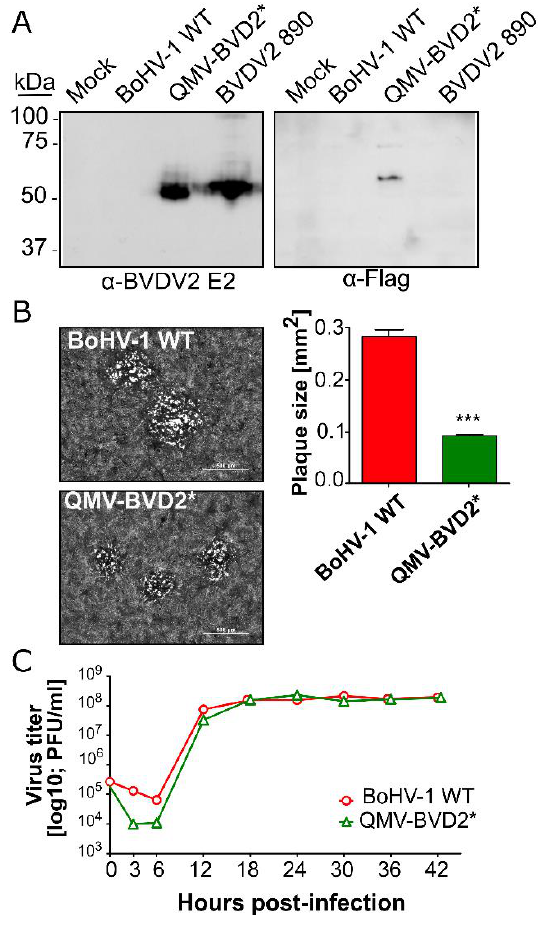
Figure 4. In vitro characterization of QMV–BVD2*. ( A ) Immunoblot analysis of QMV–BVD2* expressing chimeric BVDV2 E2 and Flag–tagged Erns–GM–CSF proteins by using anti BVDV2 E2–specific (left panel) and anti–Flag–specific (right panel) antibodies, respectively. ( B ) Plaque size analysis of QMV–BVD2* compared to that of BoHV–1 wt. Shown are the pictures of areas containing two–three representative plaques of each virus. The bar graph shows the average plaque size of at least 50 plaques with SD (*** p < 0.001). ( C ) One–step growth analysis of QMV–BVD2* compared with the BoHV–1 wt.